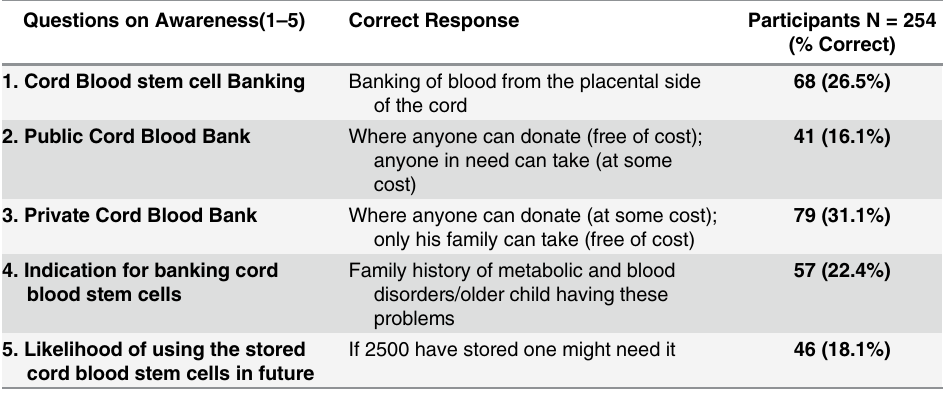
Table 2. Awareness regarding stem cell